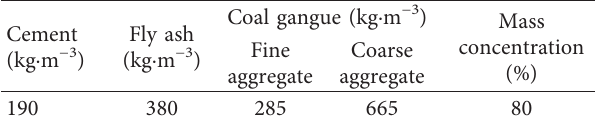
Table 2: Proportion of CGBM mixture.